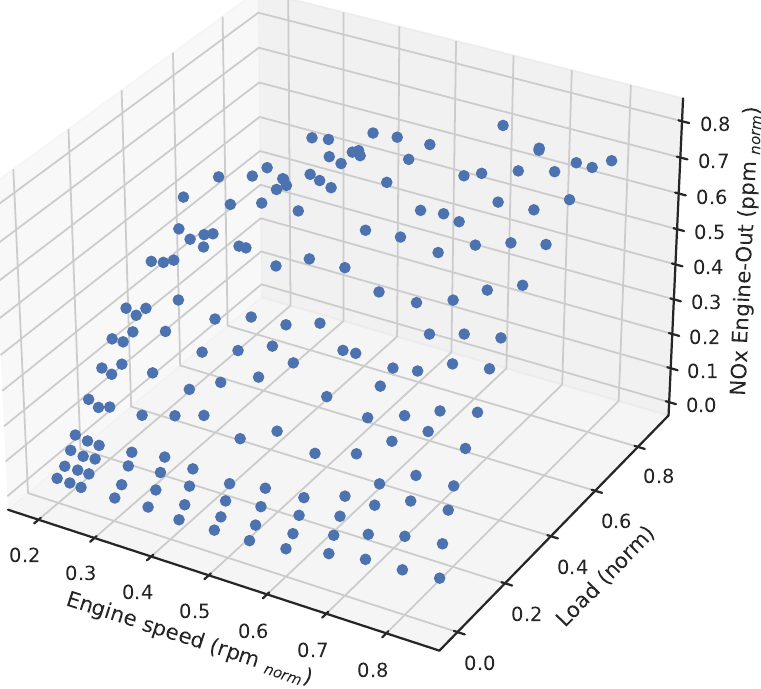
Figure 2. NOx engine-out concentration under steady-state conditions depending on engine speed and